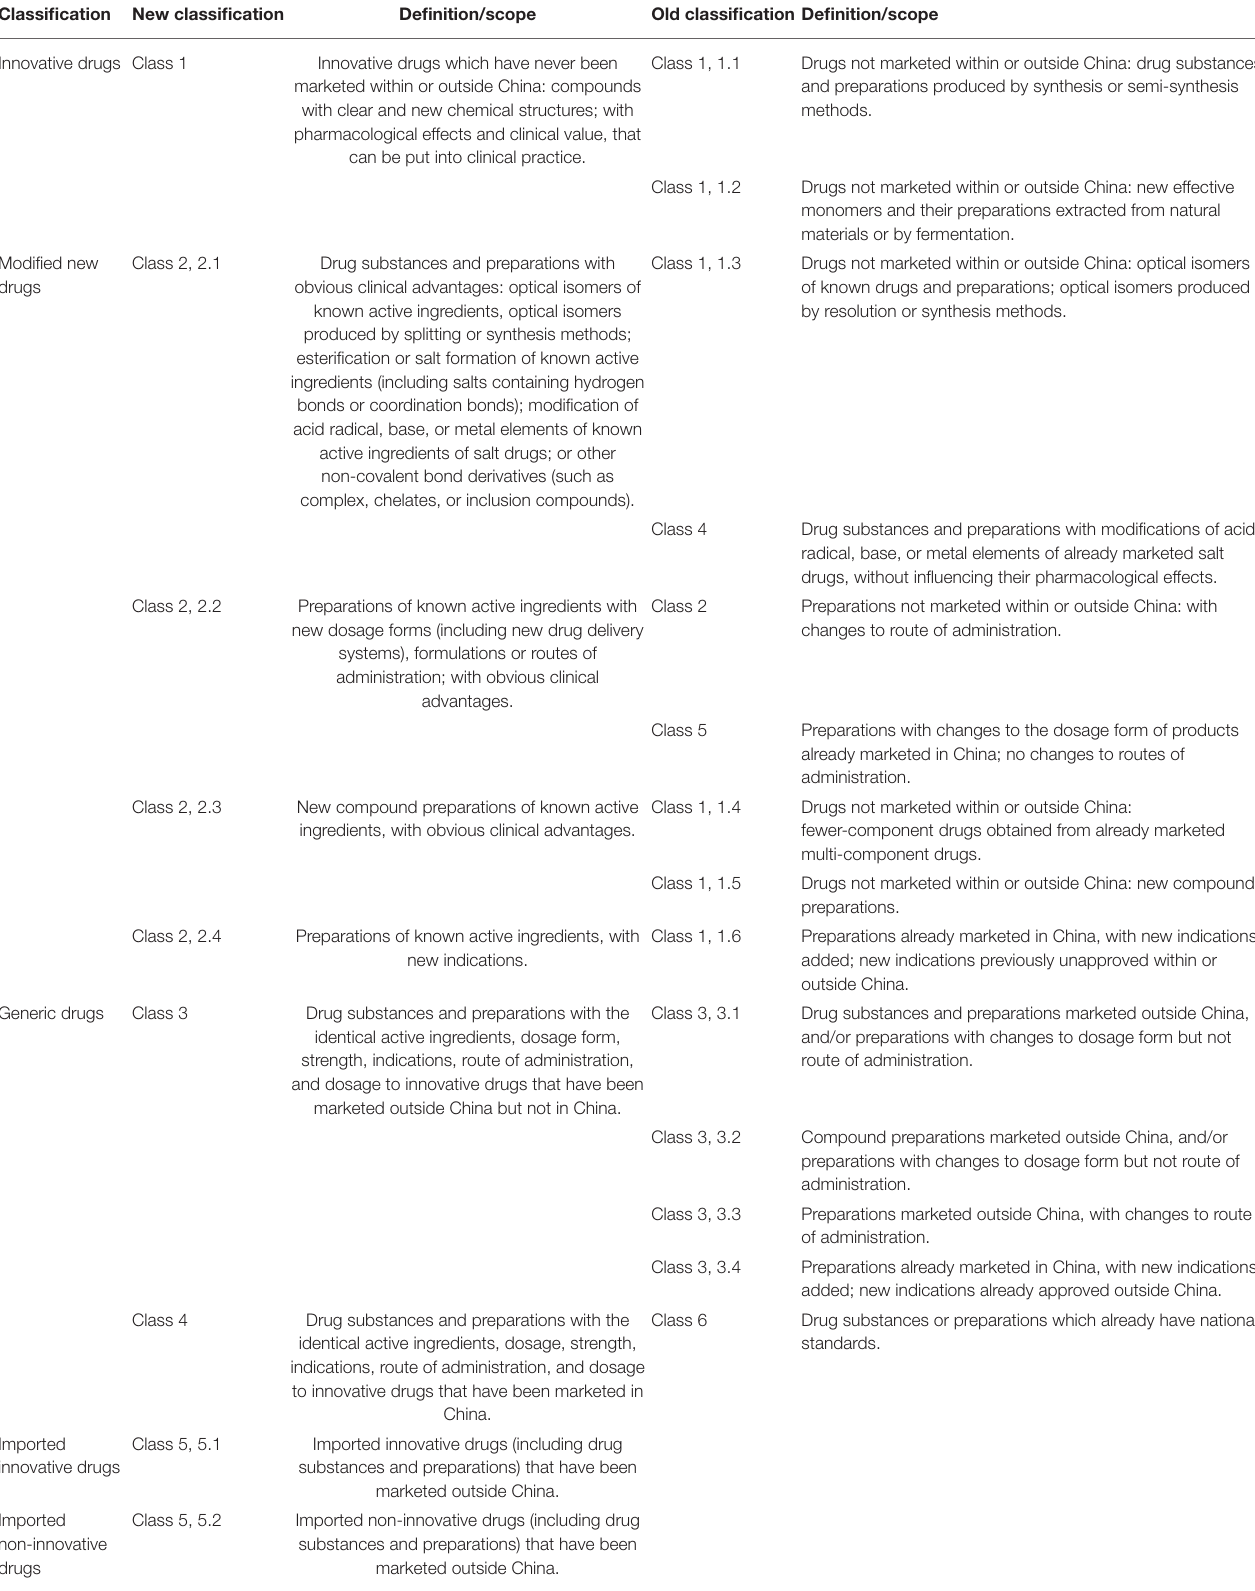
TABLE 7 | Classification system for registration of chemical